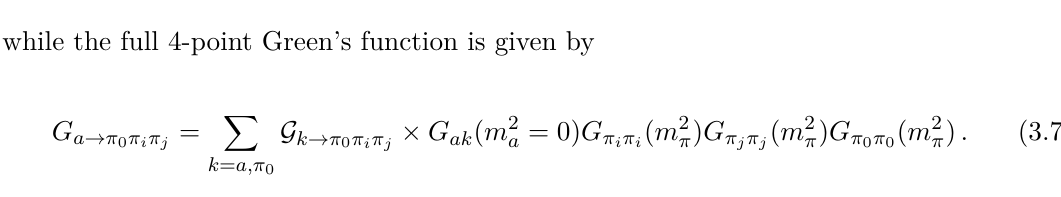
Figure 1 . One-loop diagrams contributing to the ALP decay a → π 0 π + π −